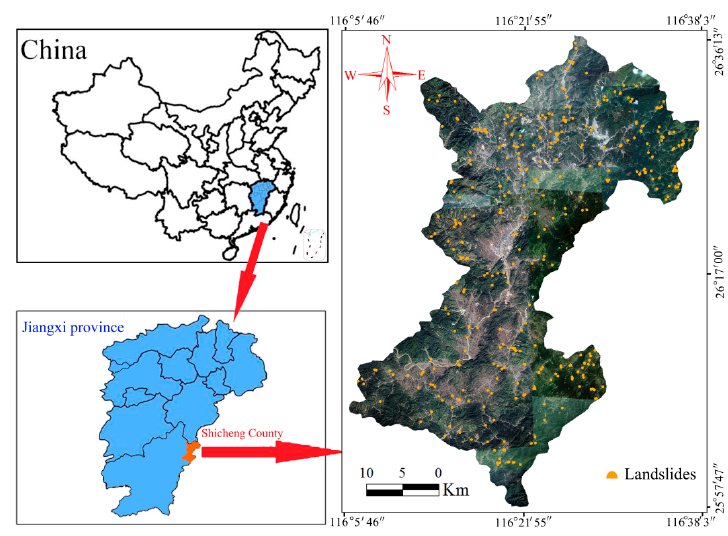
Figure 1. Geographic location and landslide distribution of Shicheng County.